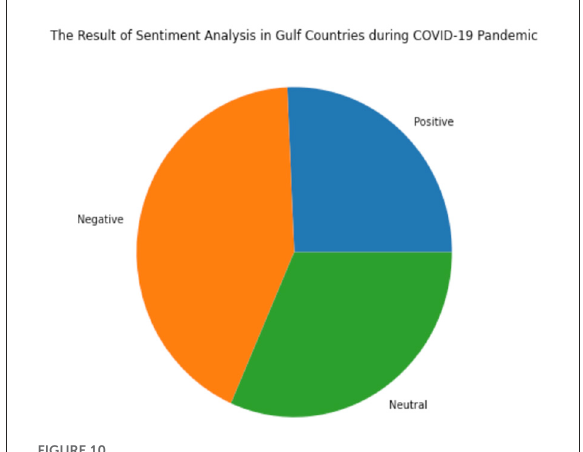
FIGURE10 The result of Sentiment Analysis in Gulf Countries during the COVID-19 pandemic.